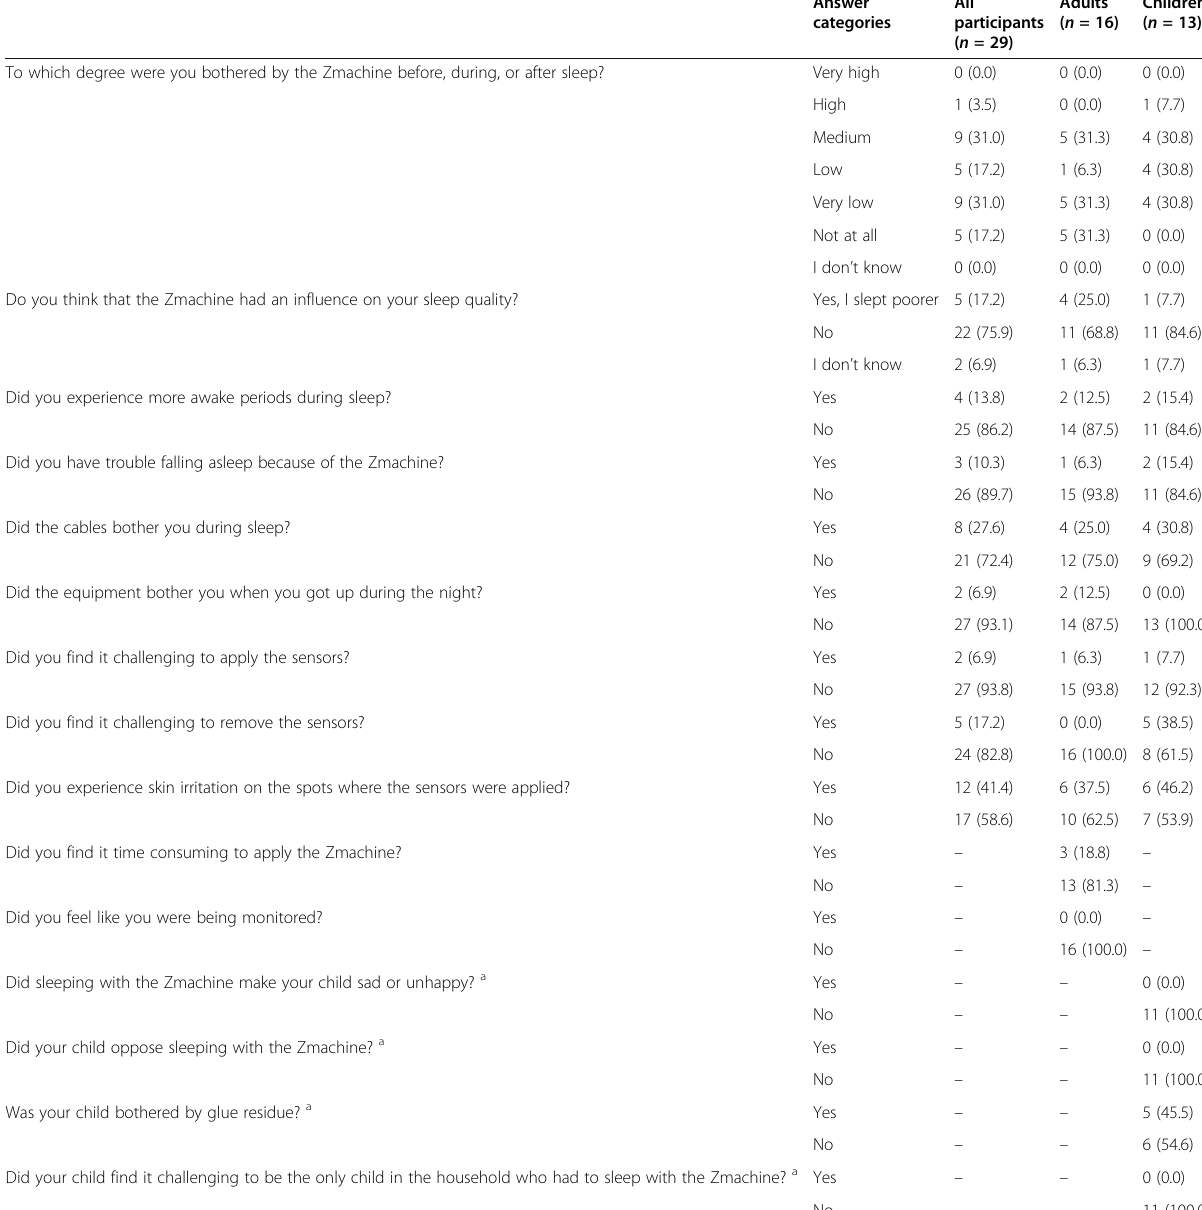
Table 3 Perceived feasibility of the